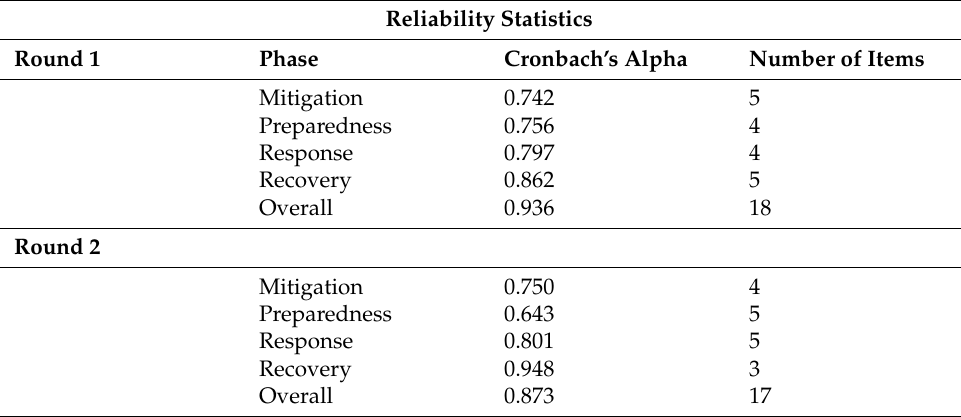
Table 2. The results of the Cronbach alpha